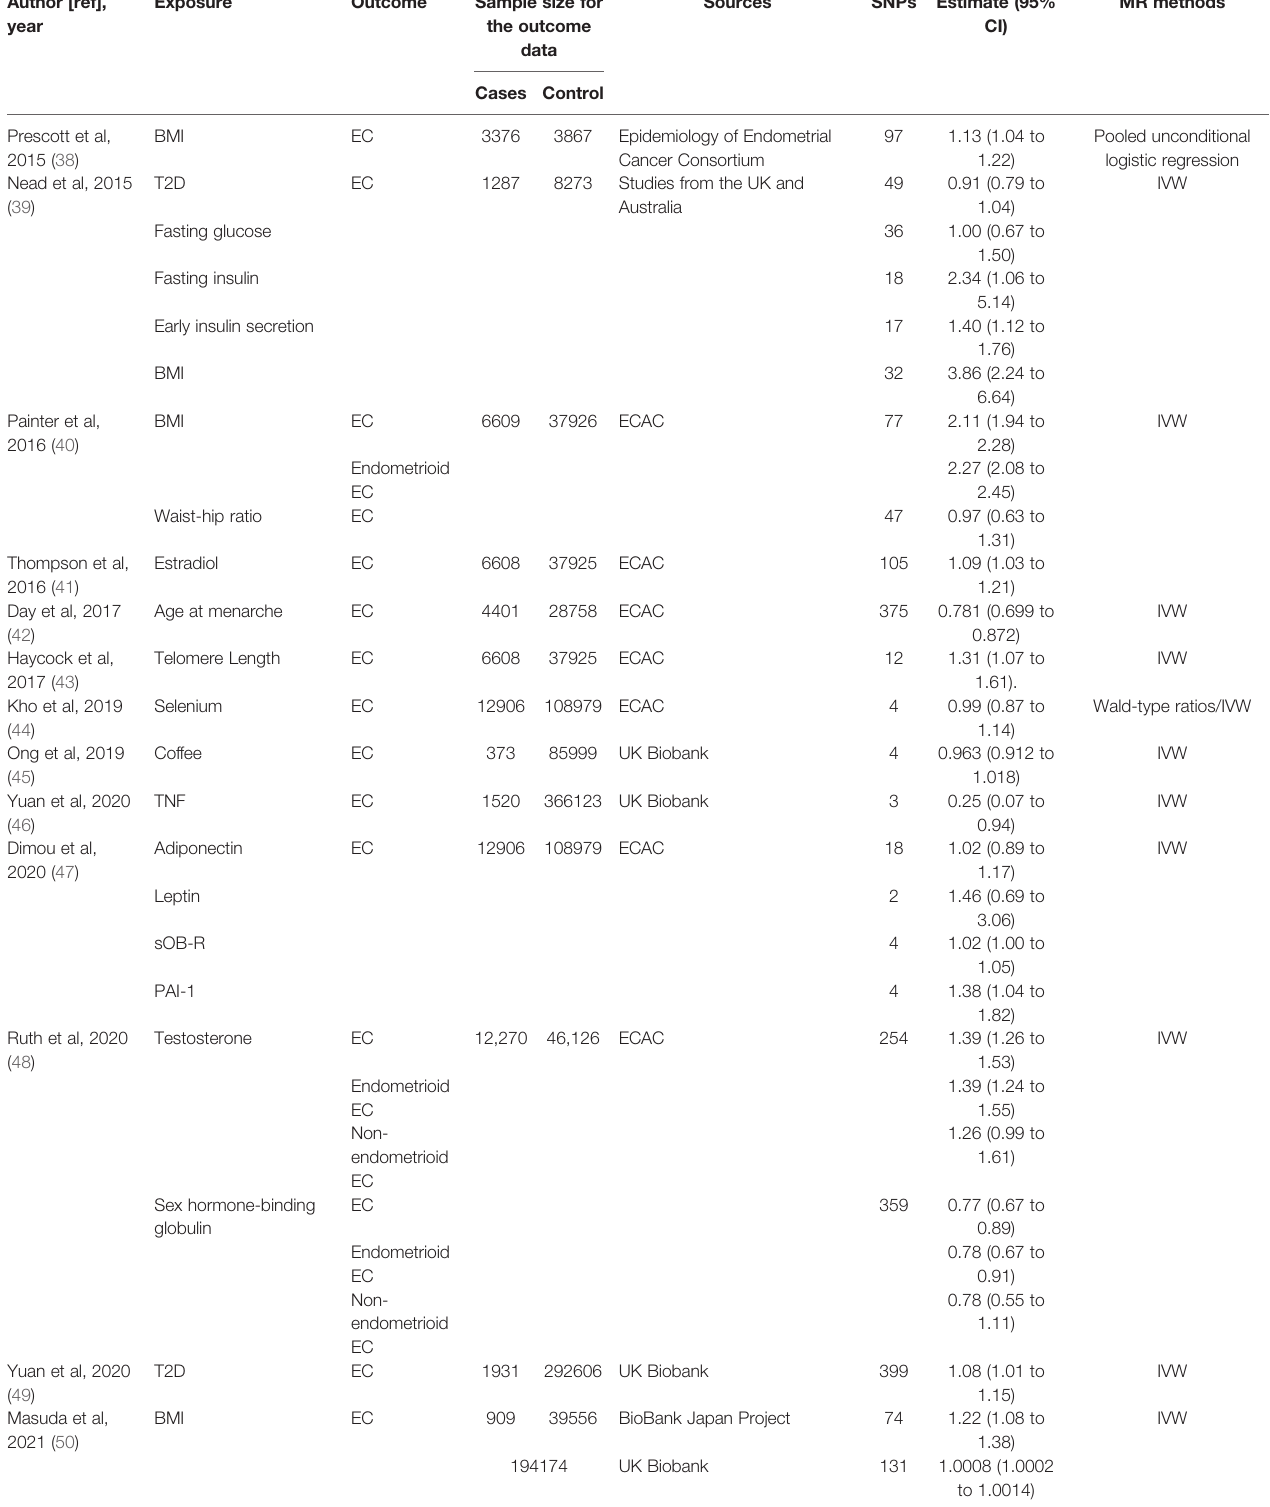
TABLE 1 | Mendelian randomization studies on endometrial